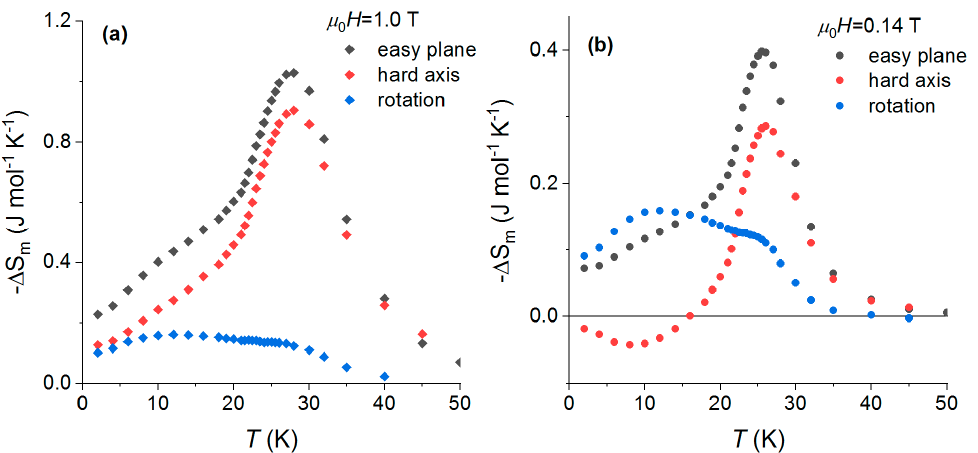
Figure 28. The magnetic entropy change for 10 due to application of the magnetic field 0- μ 0 H (black- easy plane, red -hard axis) and by rotating the crystals in constant field μ 0 H . ( a ) μ 0 H = 1.0 T, ( b ) μ 0 H = 0.14 T.